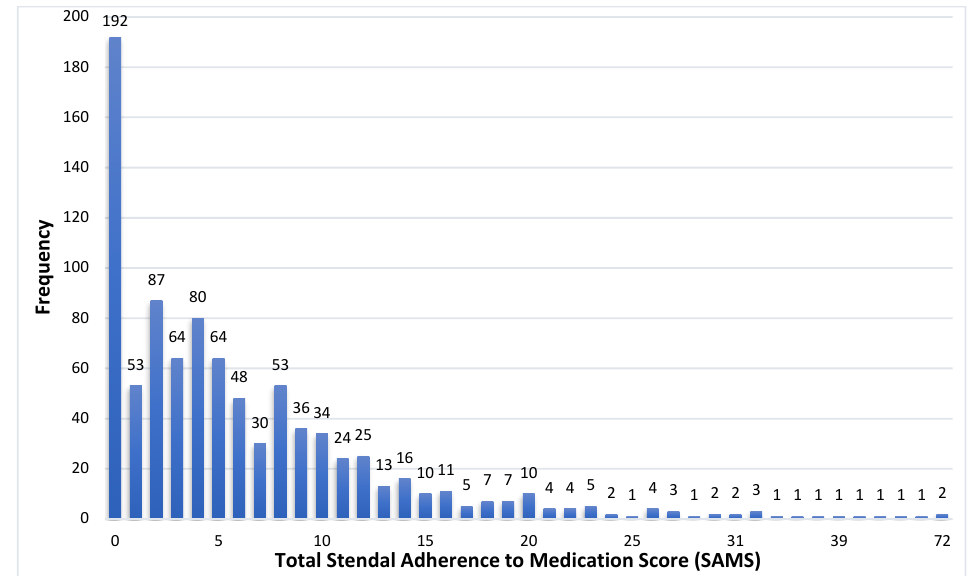
Figure 2. Histogram of the Stendal Adherence to Medication Score (SAMS). Table 2. Summary of elastic net regularization for SAMS and SAMS different reasons for nonadherence (see Supplement Table S3 for the item classification ).